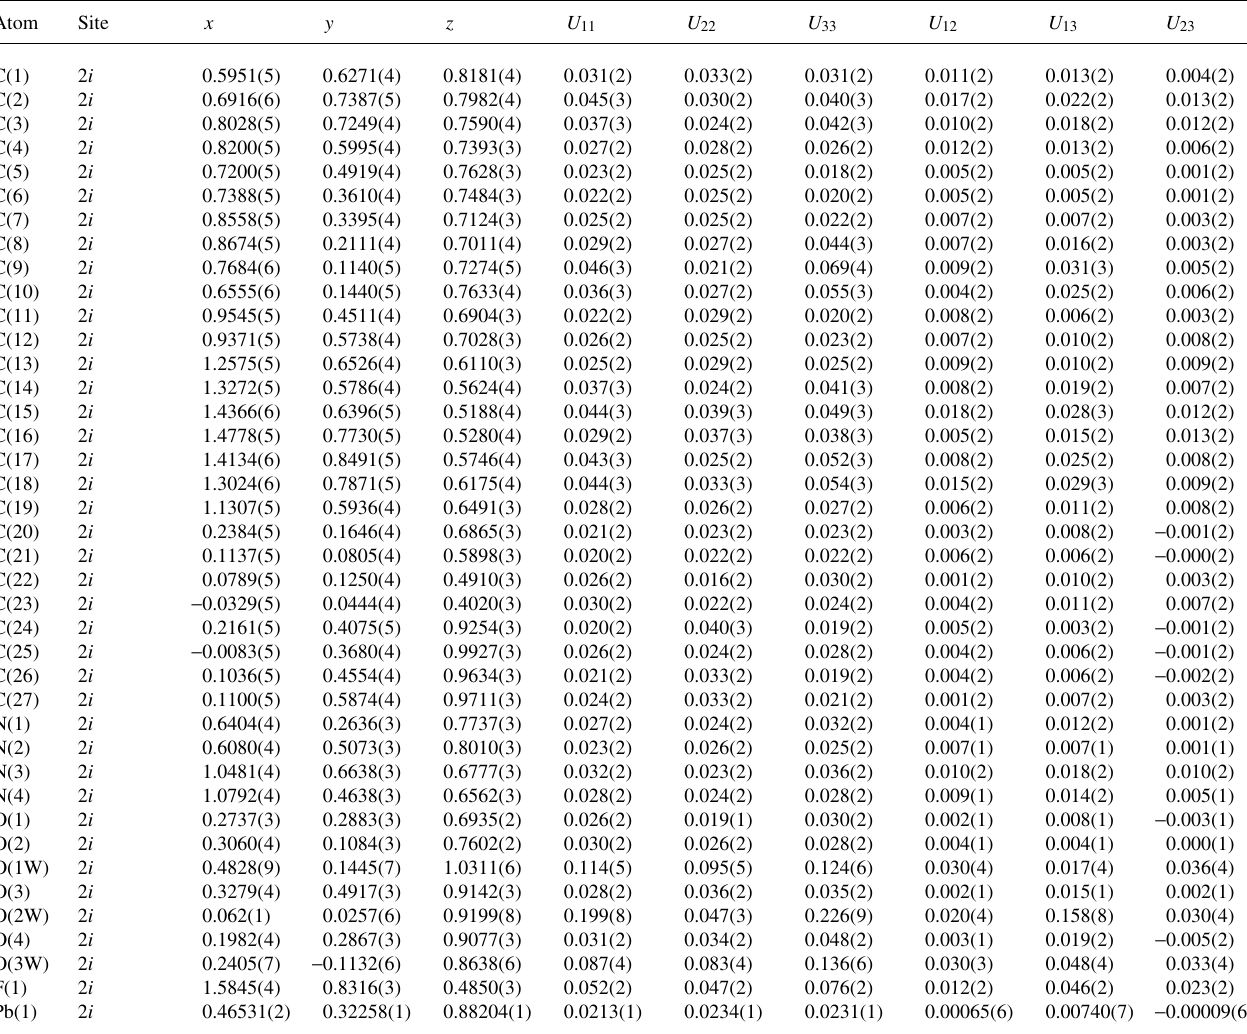
Table 3. Atomic coordinates and displacement parameters (in Å 2 )